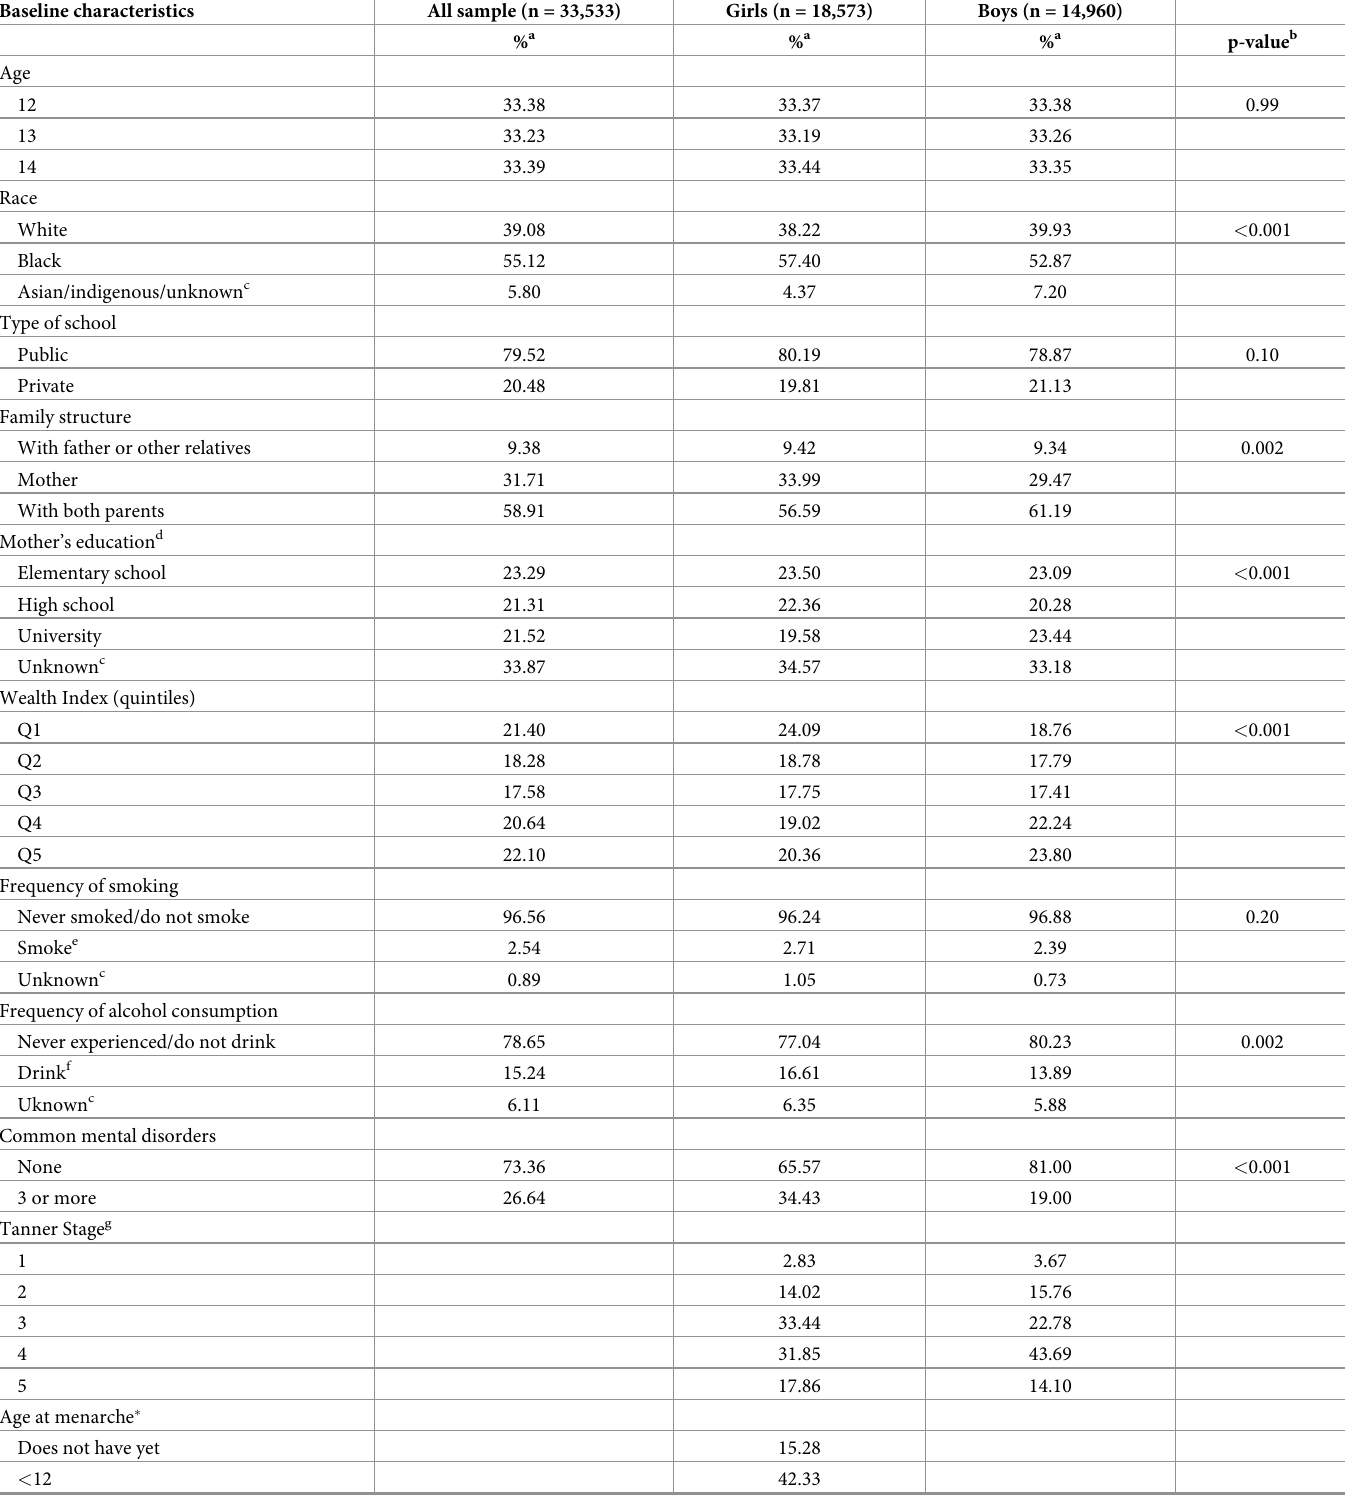
Table 1. Baseline adolescent’s characteristics stratified by sex, ERICA study, Brazil (n = 33,533). Baseline